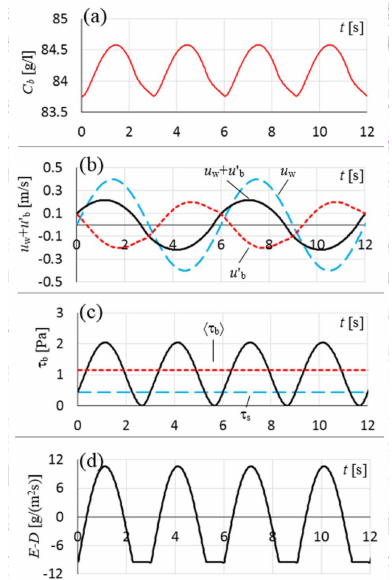
Figure 8. Main parameter configuration with u a = 40 cm/s and C * = 180 g/L. Shown are sequences of 12 s in duration starting after 10 min of simulation of ( a ) near-bed suspended-sediment concentration; C b ; ( b ) near-bed horizontal velocity, u w + u ’ b ; ( c ) bed shear stress, τ b , and bed shear strength, τ s ; and ( d ) net sediment flux across the seabed, E − D . The average bed shear stress is < τ b > ≈ 1.16 Pa. The average bed shear strength is < τ s > ≈ 0.44